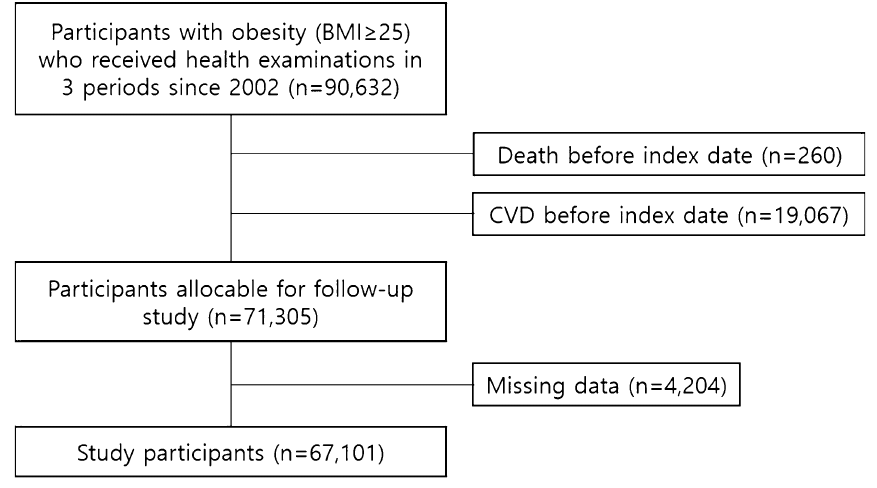
Figure 1. Participant inclusion